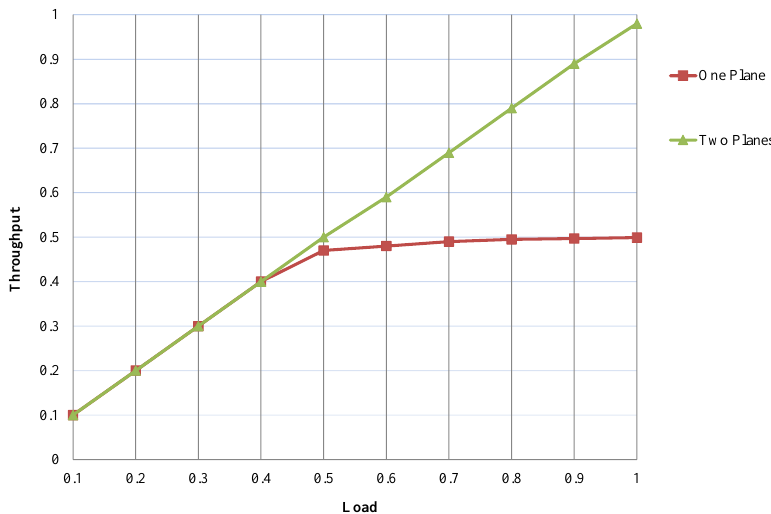
Figure 15. Throughput of optical tunnel switching network with 25 nodes.